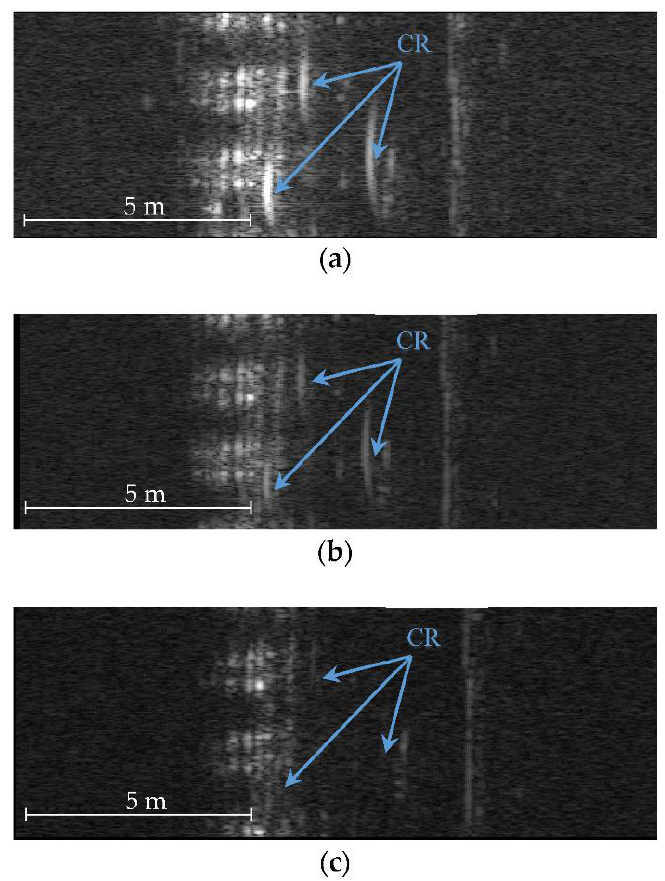
Figure 4. Range-compressed images for ( a ) B = 0.27 m, ( b ) 0.5 m, and ( c ) 1 m. Note: trihedral corner reflector signals (CR) are completely lost when B = 1 m.